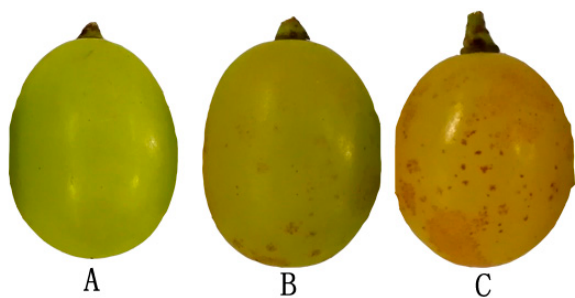
Figure 1. ‘Sunshine muscat’ grapes with different degrees of the russet phenotype: ( A ) non-russet grape, ( B ) slightly russet grape, and ( C ) extremely russet grape.